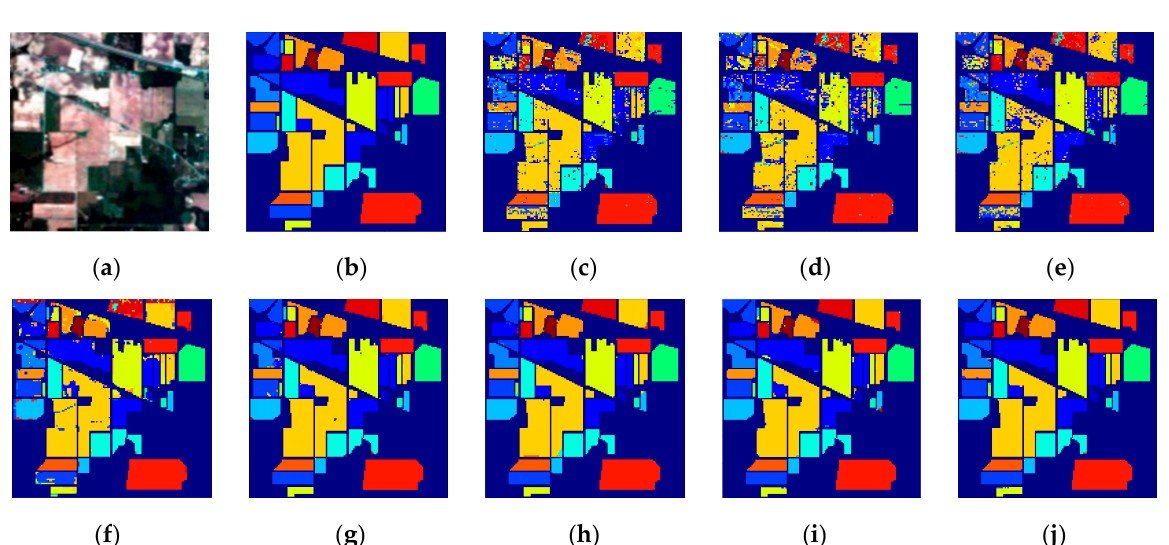
Figure 9. Classification maps for the Indian Pines dataset. ( a ) False-color image. ( b ) Ground truth. ( c ) SVM. ( d ) PCA. ( e ) LSTM. ( f ) 3DCNN. ( g ) SSRN. ( h ) DFFN. ( i ) MSCNN. ( j ) SSDF.